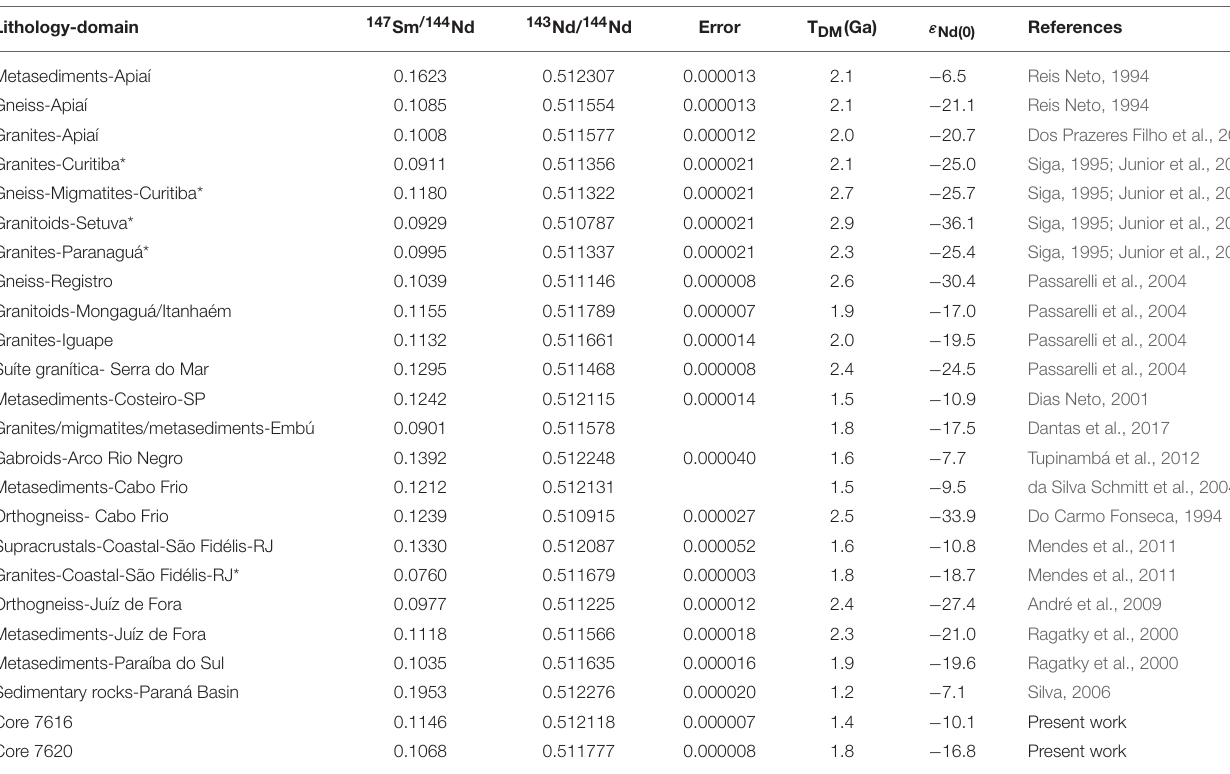
TABLE 3 | Nd isotope systematic averages of potential